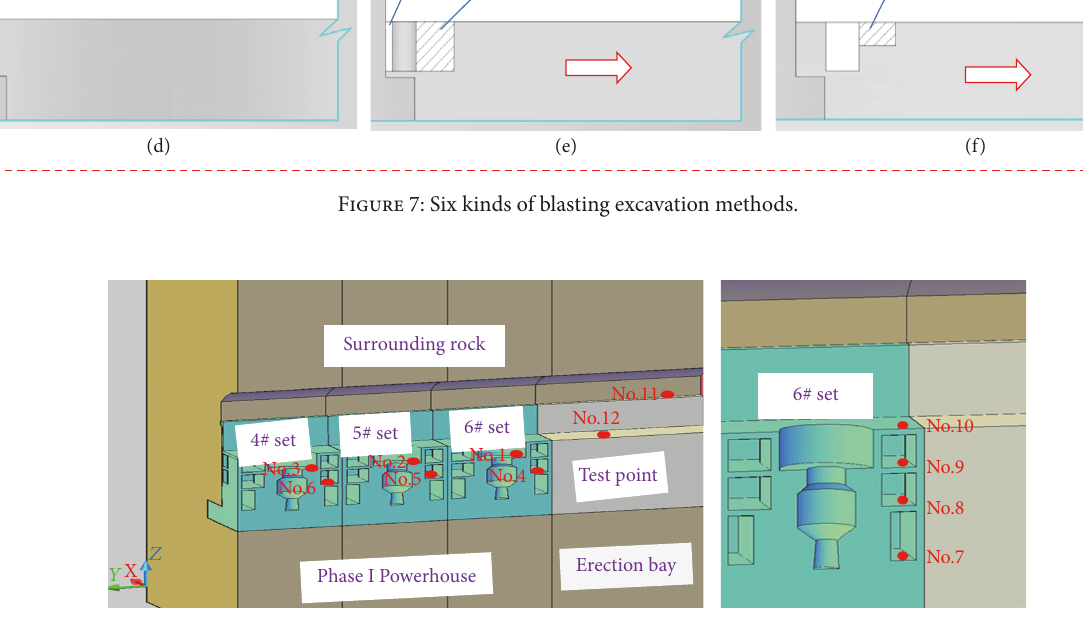
Figure 8: Monitoring points of